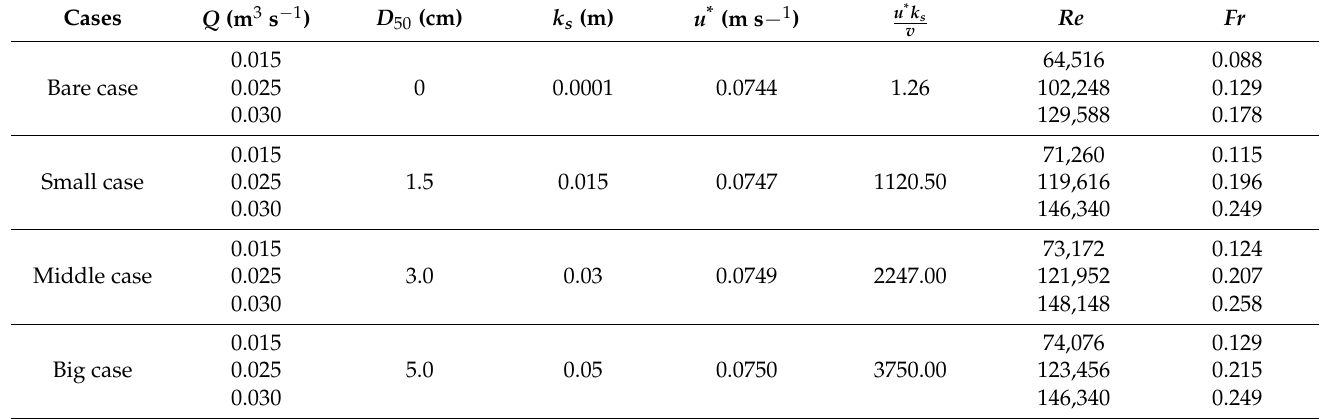
Table 1. Parameters of the